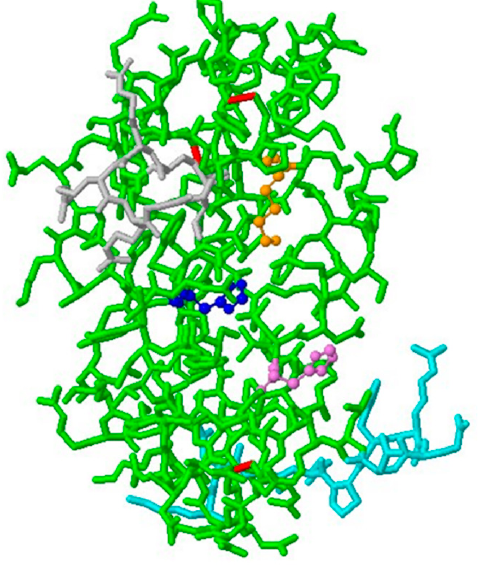
Figure 3. Three-dimensional biological structure of human ANG, consisting of: three disulphide bridges (in red); a catalytic site formed by the triad His-13 (in blue), Lys-40 (in orange) and His-114 (in violet); the receptor binding site, sequence 60–68 (in cyan); the nuclear translocation sequence, 30–35 (in grey). (PDB ID 1ANG, 10.2210/pdb1ANG/pdb).